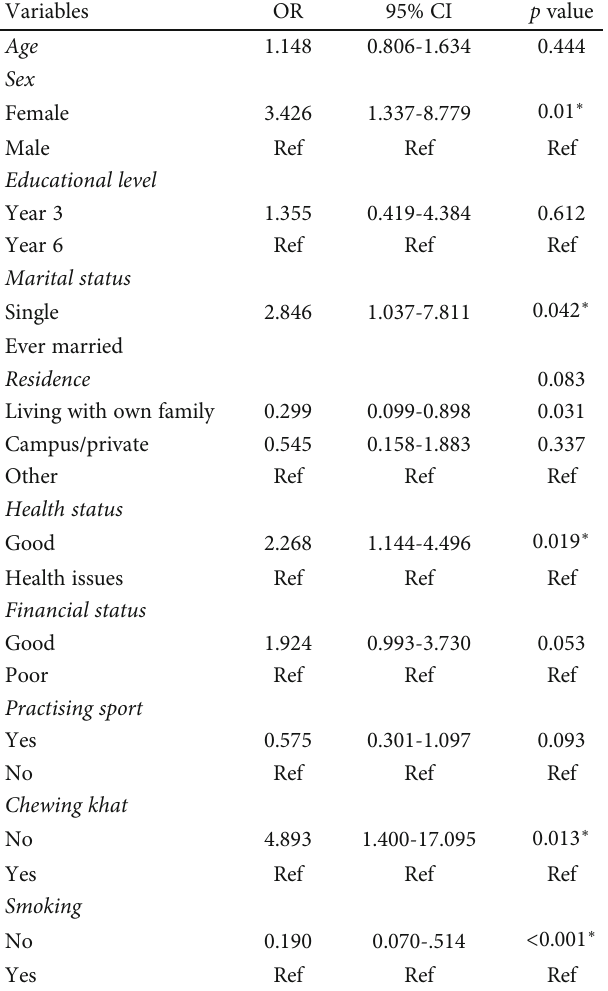
Table 2: Personal and life-style predictors of good quality of sleep among Yemeni medical